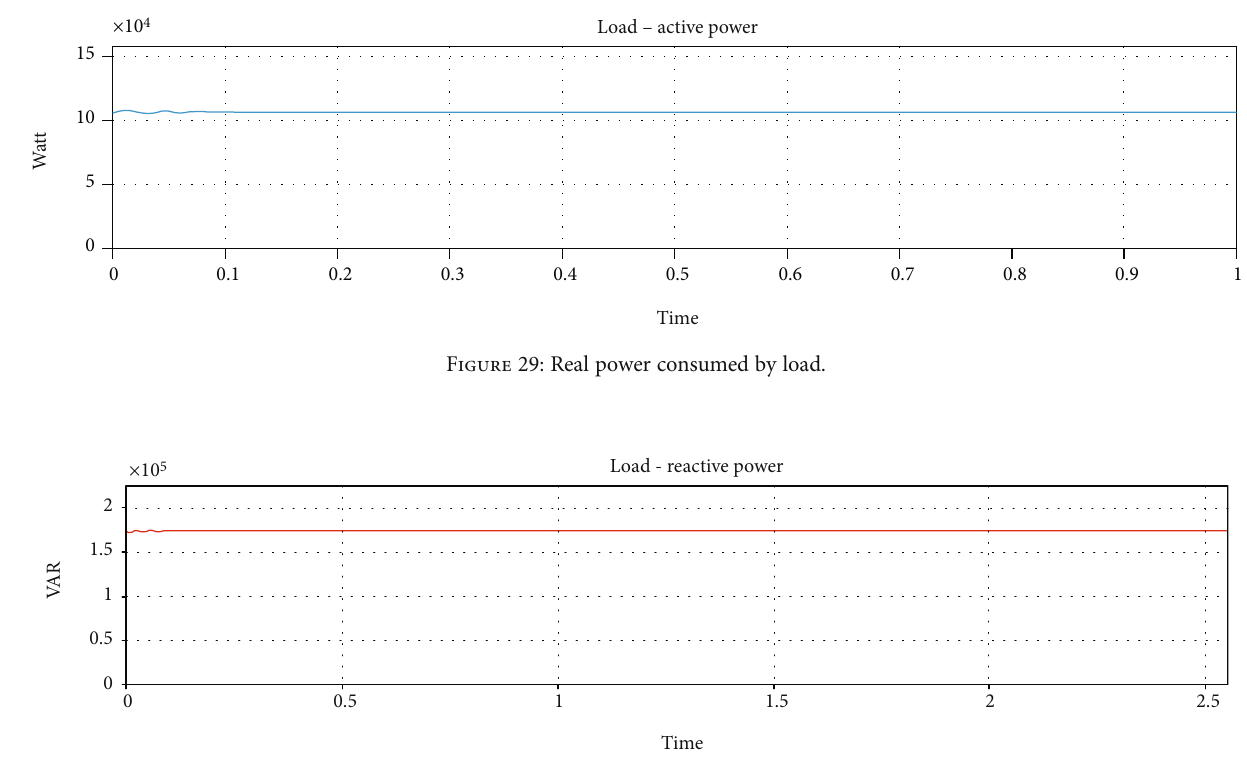
Figure 30: Reactive power consumed by the load.